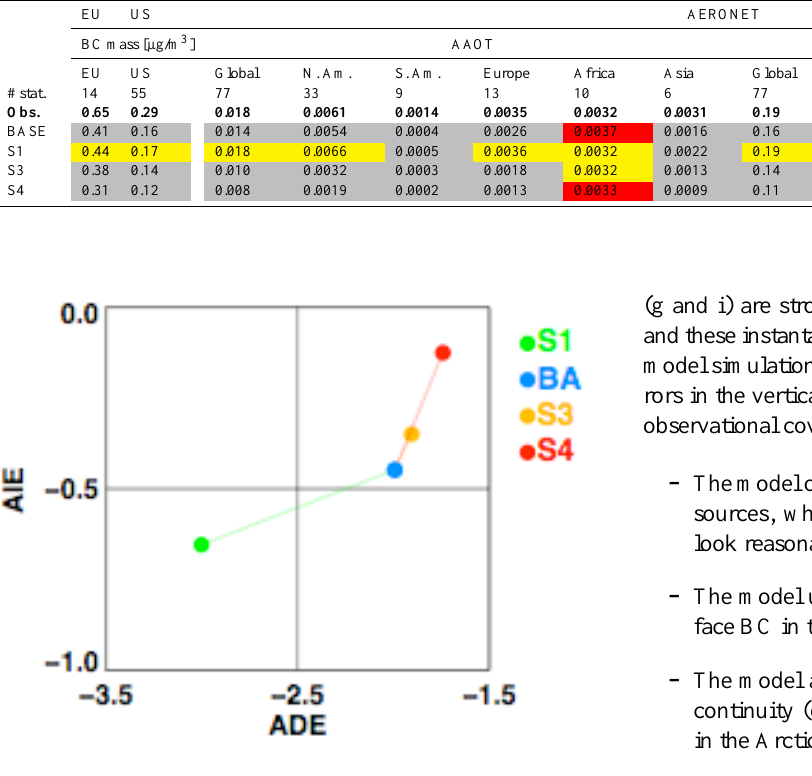
Fig. 4. Global mean AIE and ADE [W/m 2 ] values for all size exper- iments, (S1–4) and the base experiment, BA, for present day condi- Figure 4 Global mean AIE and ADE [W/m 2 ] values for all size experiments, (S1 – 4) and the base experiment, BA, for present day conditions.